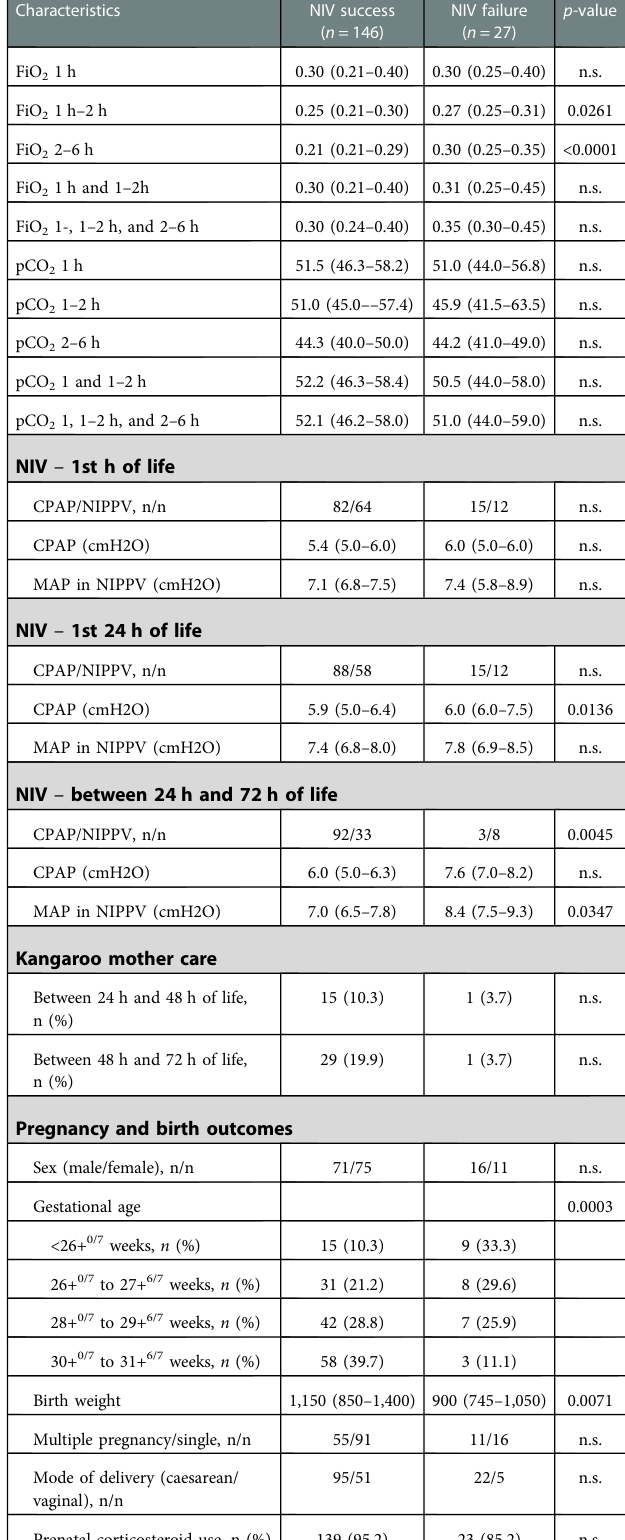
TABLE 3 Comparison of NIV success and NIV failure groups – univariate